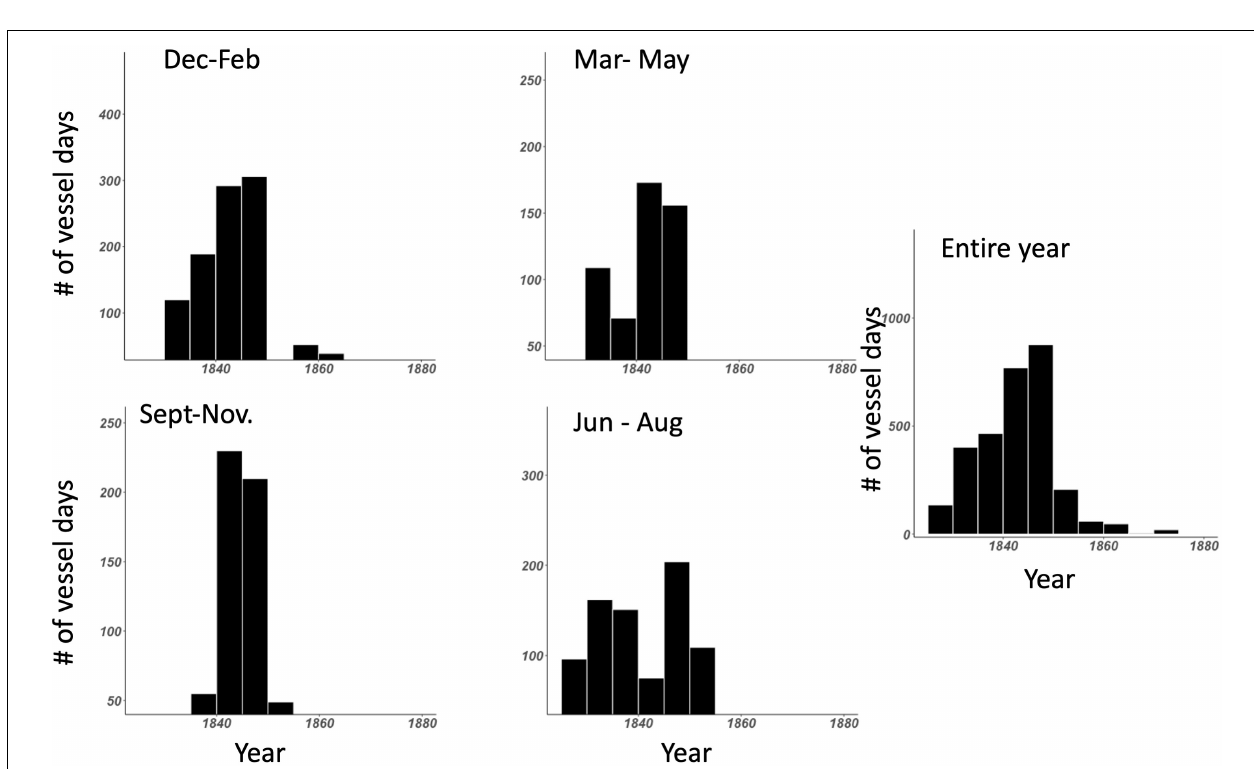
FIGURE 2 | Histograms of the effort in terms of vessel days through the data set broken out quarterly and the total for the entire Smith et al. (2012) dataset.